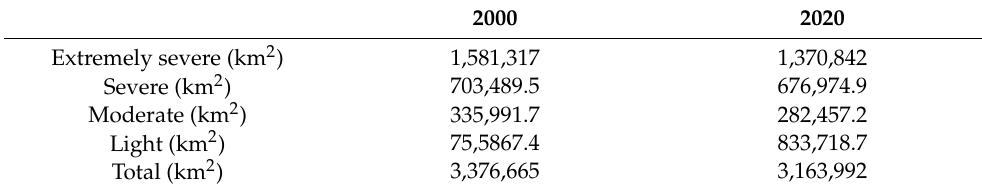
Table 5. Area changes of desertification in unchanged land-use areas.